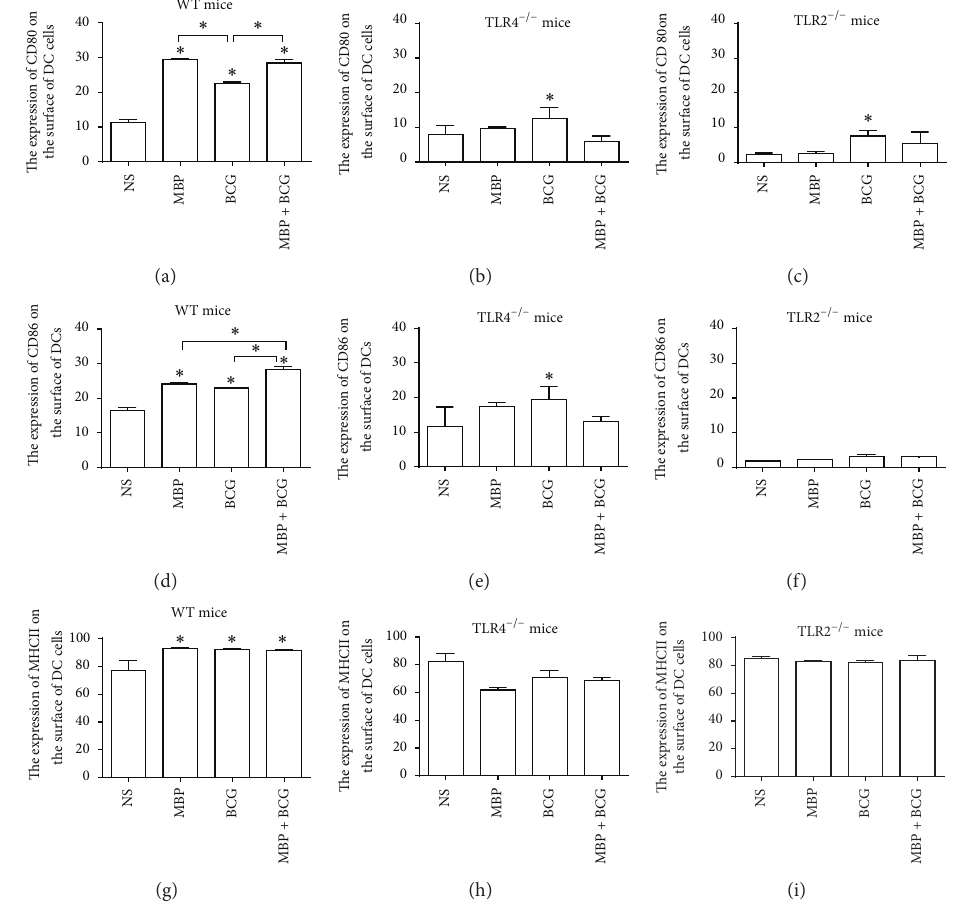
Figure 8: MBP plus BCG enhances CD80, CD86, and MHCII expression on DCs in vivo. DCs were isolated from WT mice ((a), (d), and (g)), TLR4 −/− mice ((b), (e), and (h)), or TLR2 −/− mice ((c), (f), and (i)) immunized with MBP, BCG, or the combination of MBP and BCG and were analyzed for CD80, CD86, and MHCII expression with flow cytometry. The percentage of CD11c + cells expressing CD80, CD86, and MHCII is expressed as the mean ± standard deviation and is shown in a bar graph. Data are derived from three independent experiments. ∗ 𝑃 < 0.05 is considered to indicate statistically significant differences compared with the NS group derived from WT